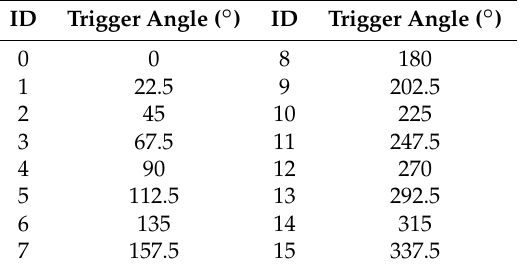
Table 6. Turn-on trigger angles.